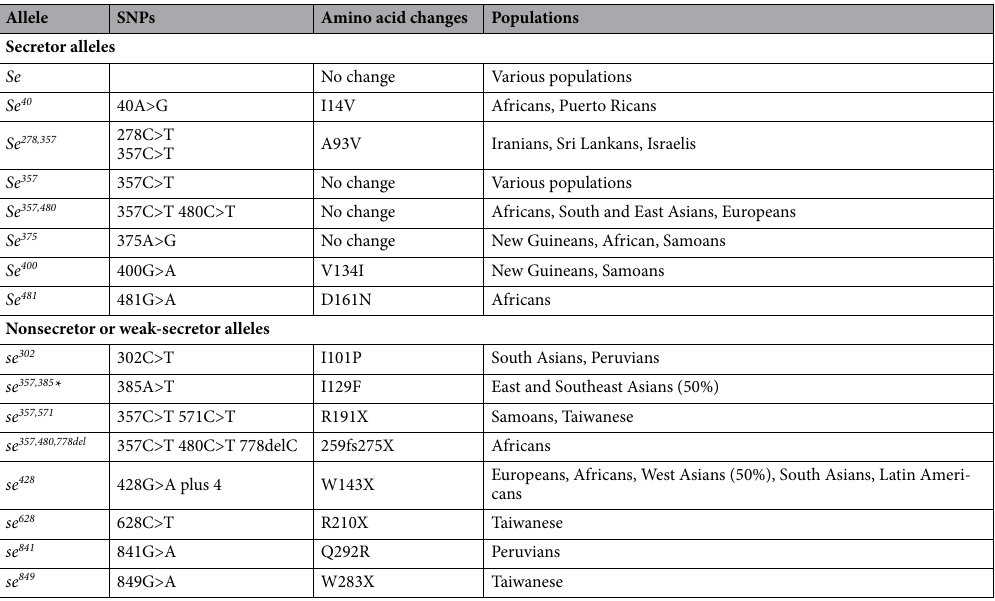
Table 1. Distribution of SNPs and alleles of FUT2 in various populations. *Represents weak secretor allele ( Se w